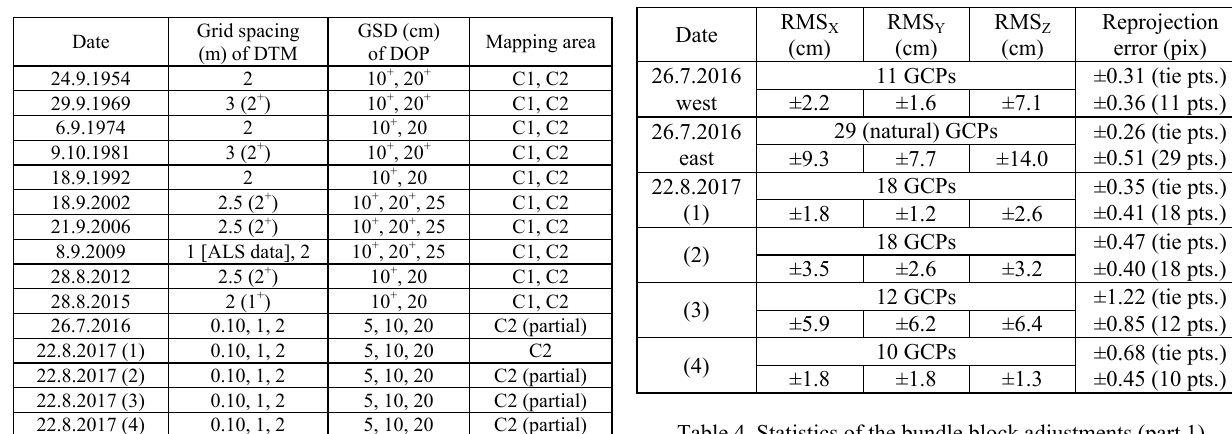
Table 4. Statistics of the bundle block adjustments (part